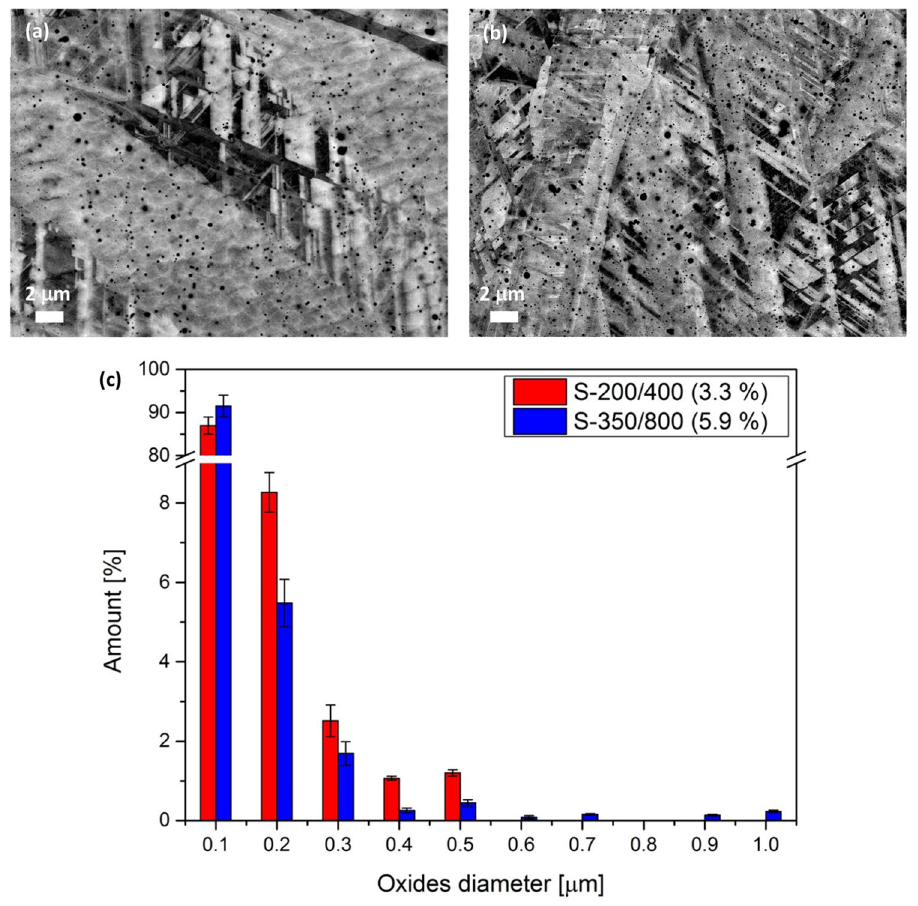
Figure 5. ECCI images of samples S-200/400 ( a ) and S-350/800 ( b ) with different amounts and sizes of small oxides in the matrix with its histogram of the diameters of the oxides ( c ).